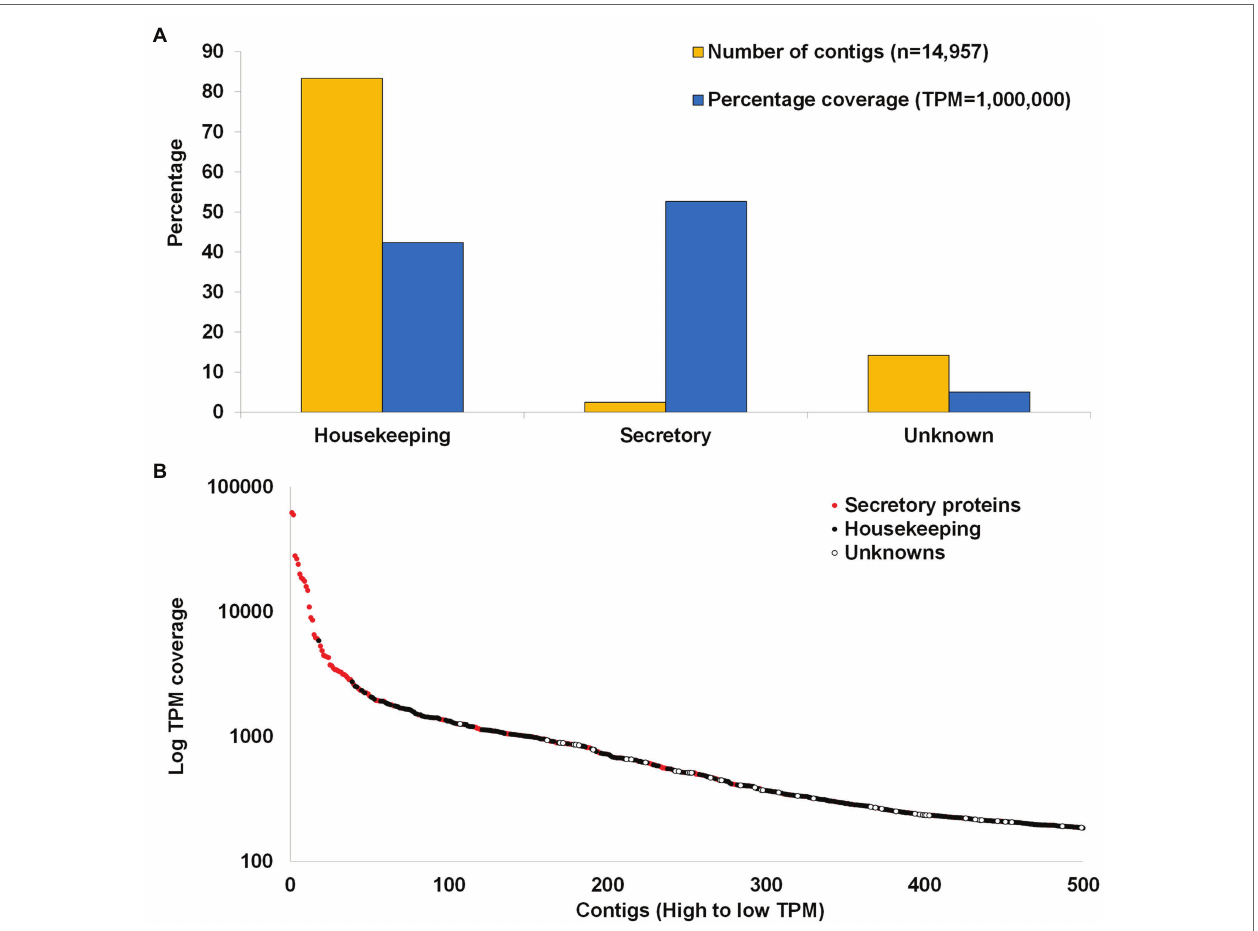
FIGURE 4 | Summary of transcriptome. (A) Comparison of the housekeeping, secretory, and unknown classes of contigs with regard to number of contigs contained in each class and the cumulative coverage of each class. (B) The first 500 contigs with the highest TPM coverage. Red dots indicate secretory proteins and black dots indicate housekeeping while white dots indicate unknown